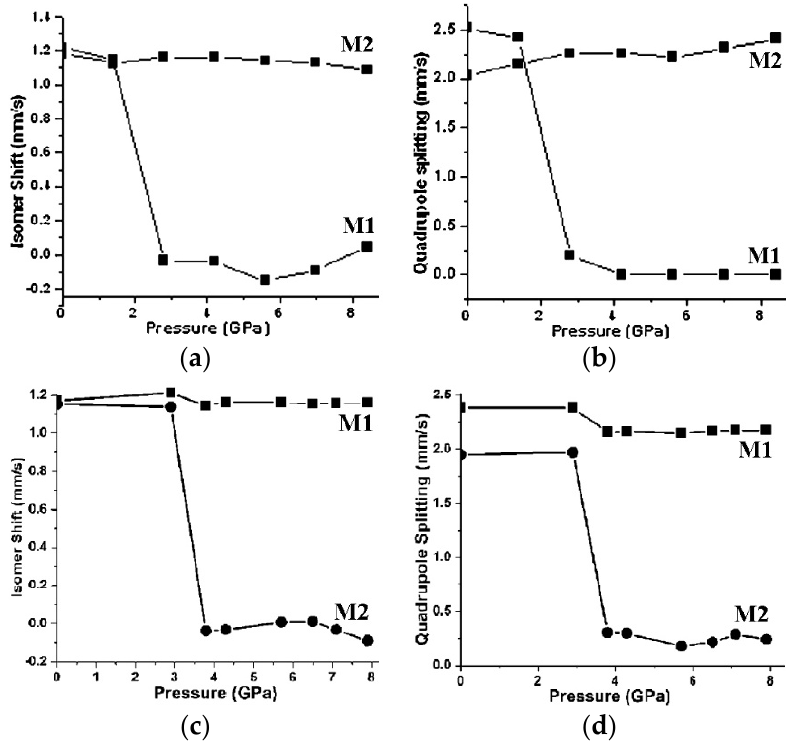
Figure 8. Different variations in the values of isomer shift ( a , c ) and quadrupole splitting ( b , d ) for the M1 and M2 sites in pyroxene vs. pressure in Lohawat howardite ( a , b ) and Piplia Kalan eucrite ( c , d ). Adapted from [22,23].